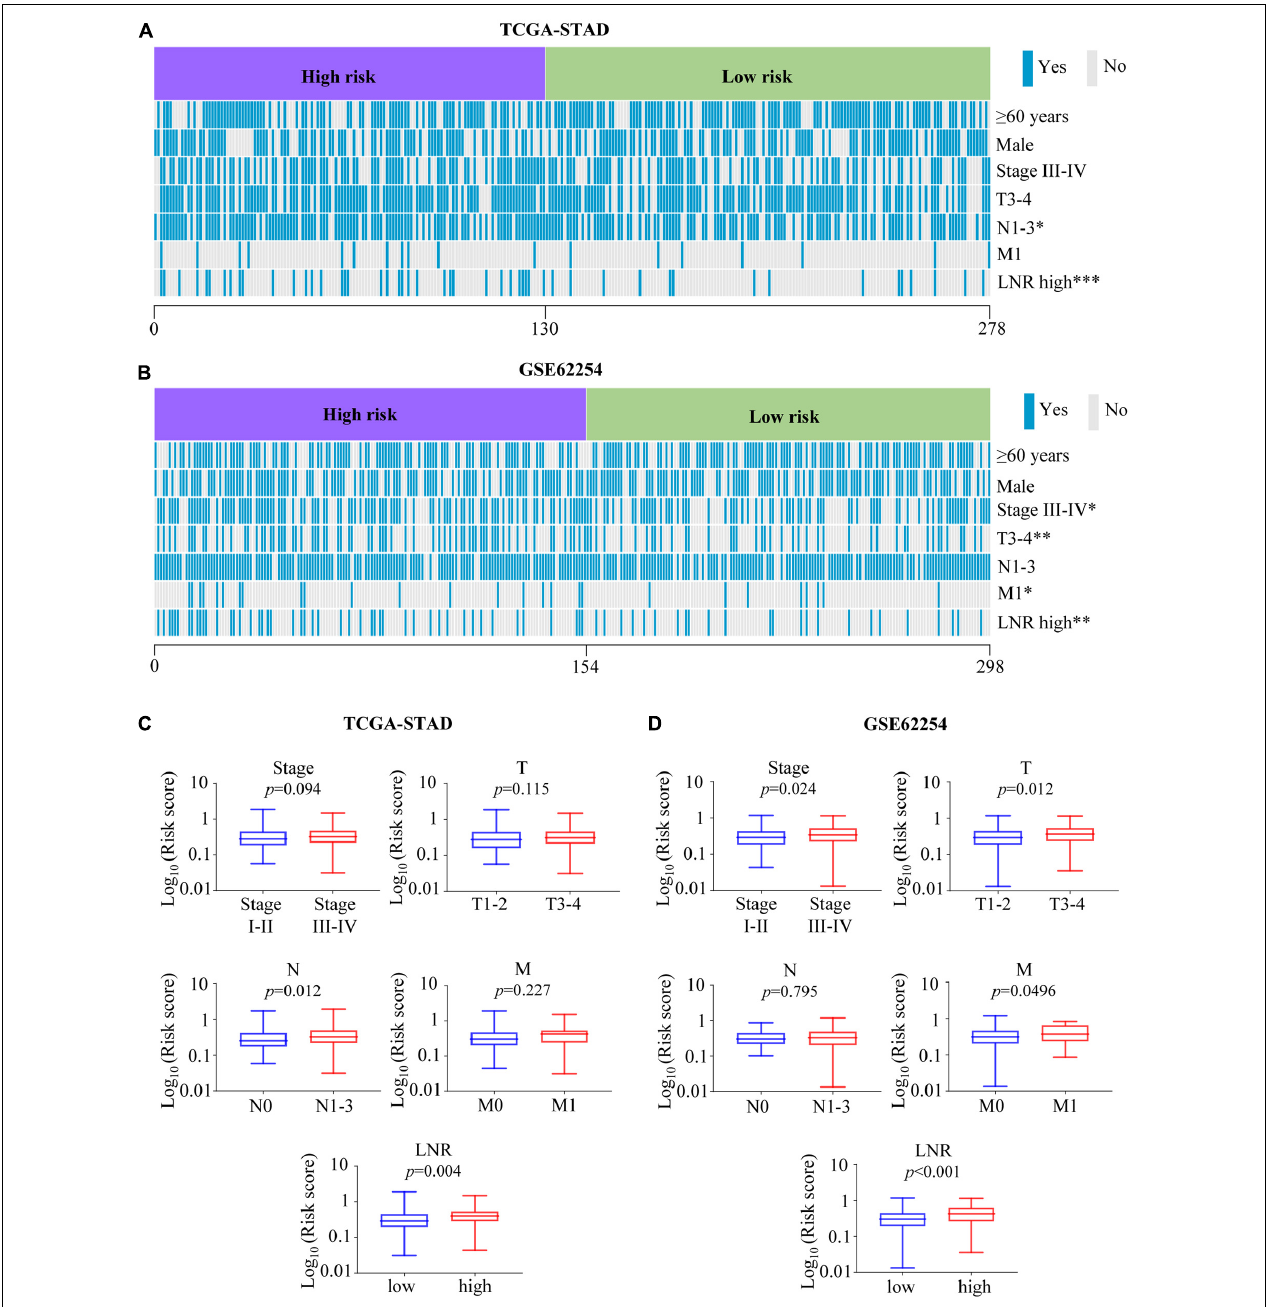
FIGURE 4 | Association between the risk score with clinical characteristics. (A,B) Heatmaps of association between the risk score with clinical characteristics in the TCGA-STAD (A) and GSE62254 (B) cohorts. (C,D) Comparisons of risk score among different clinical subgroups stratified based on stage, T, N, M, and LNR in the TCGA-STAD (C) cohort and GSE62254 (D) cohort. ∗ p < 0.05, ∗∗ p < 0.01, ∗∗∗ p <